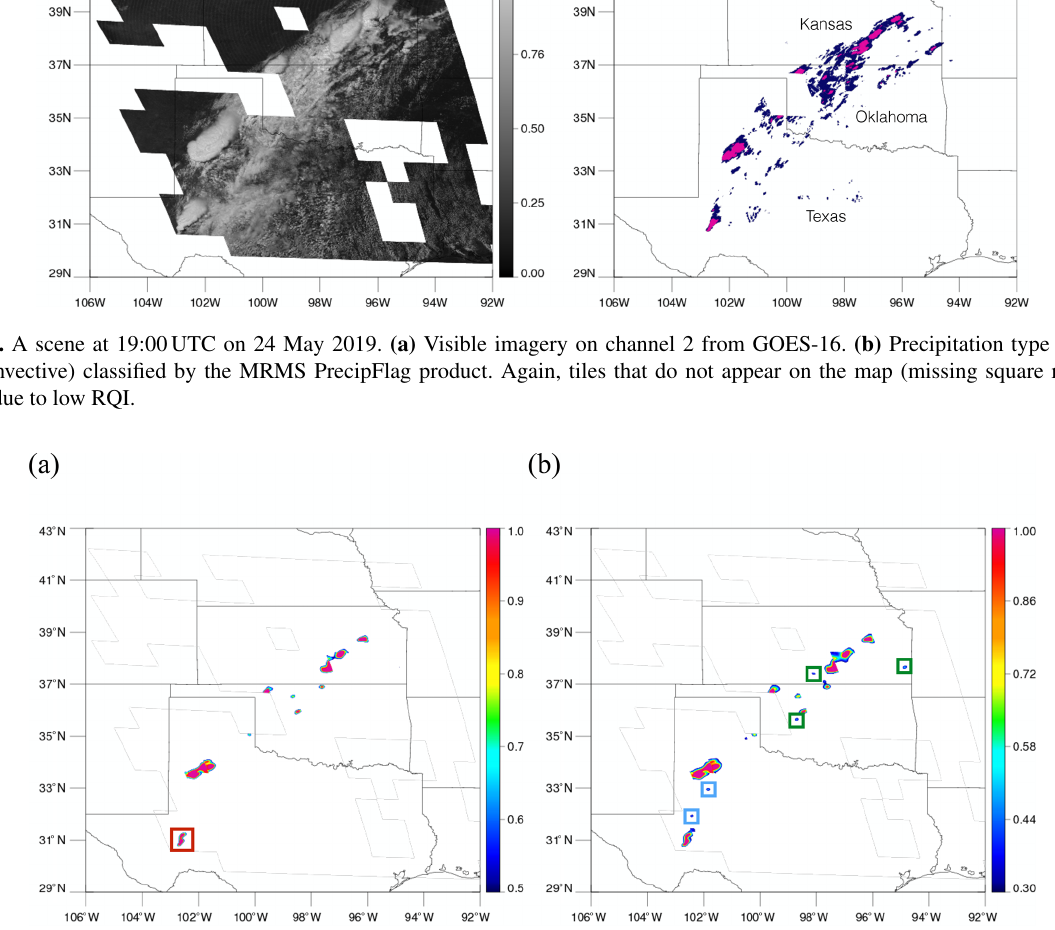
Figure 12. Predicted convective regions by the model using a threshold of (a) 0.5 and (b) 0.3. Colors represent a scale of being convective (1 being convective and 0 being